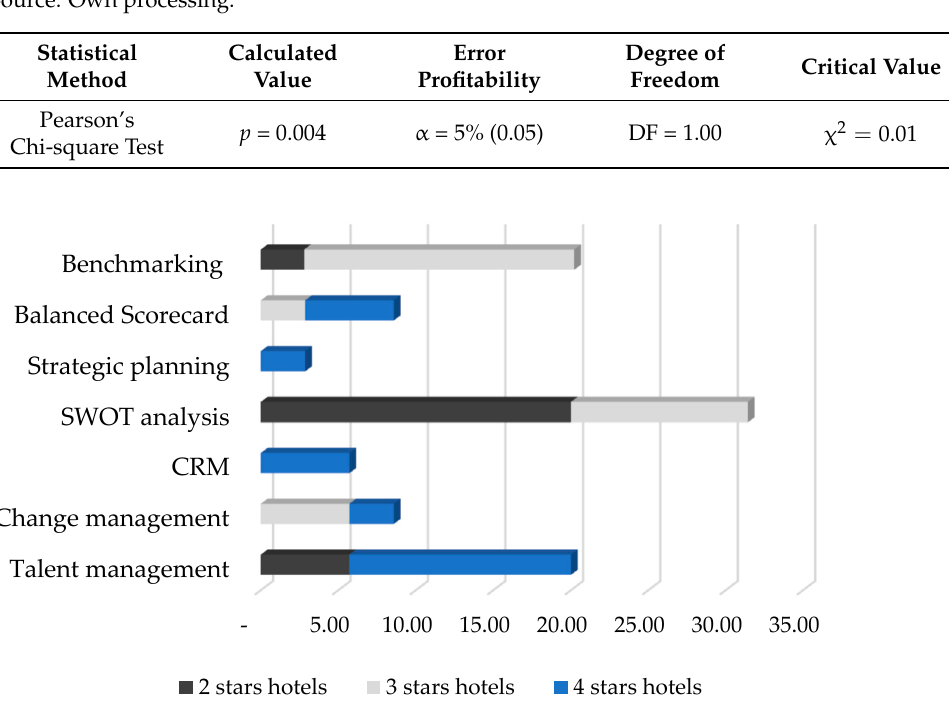
Table 3. The results of testing 2 hypothesis using the Pearson’s Chi-square test of independence. Source: Own processing.